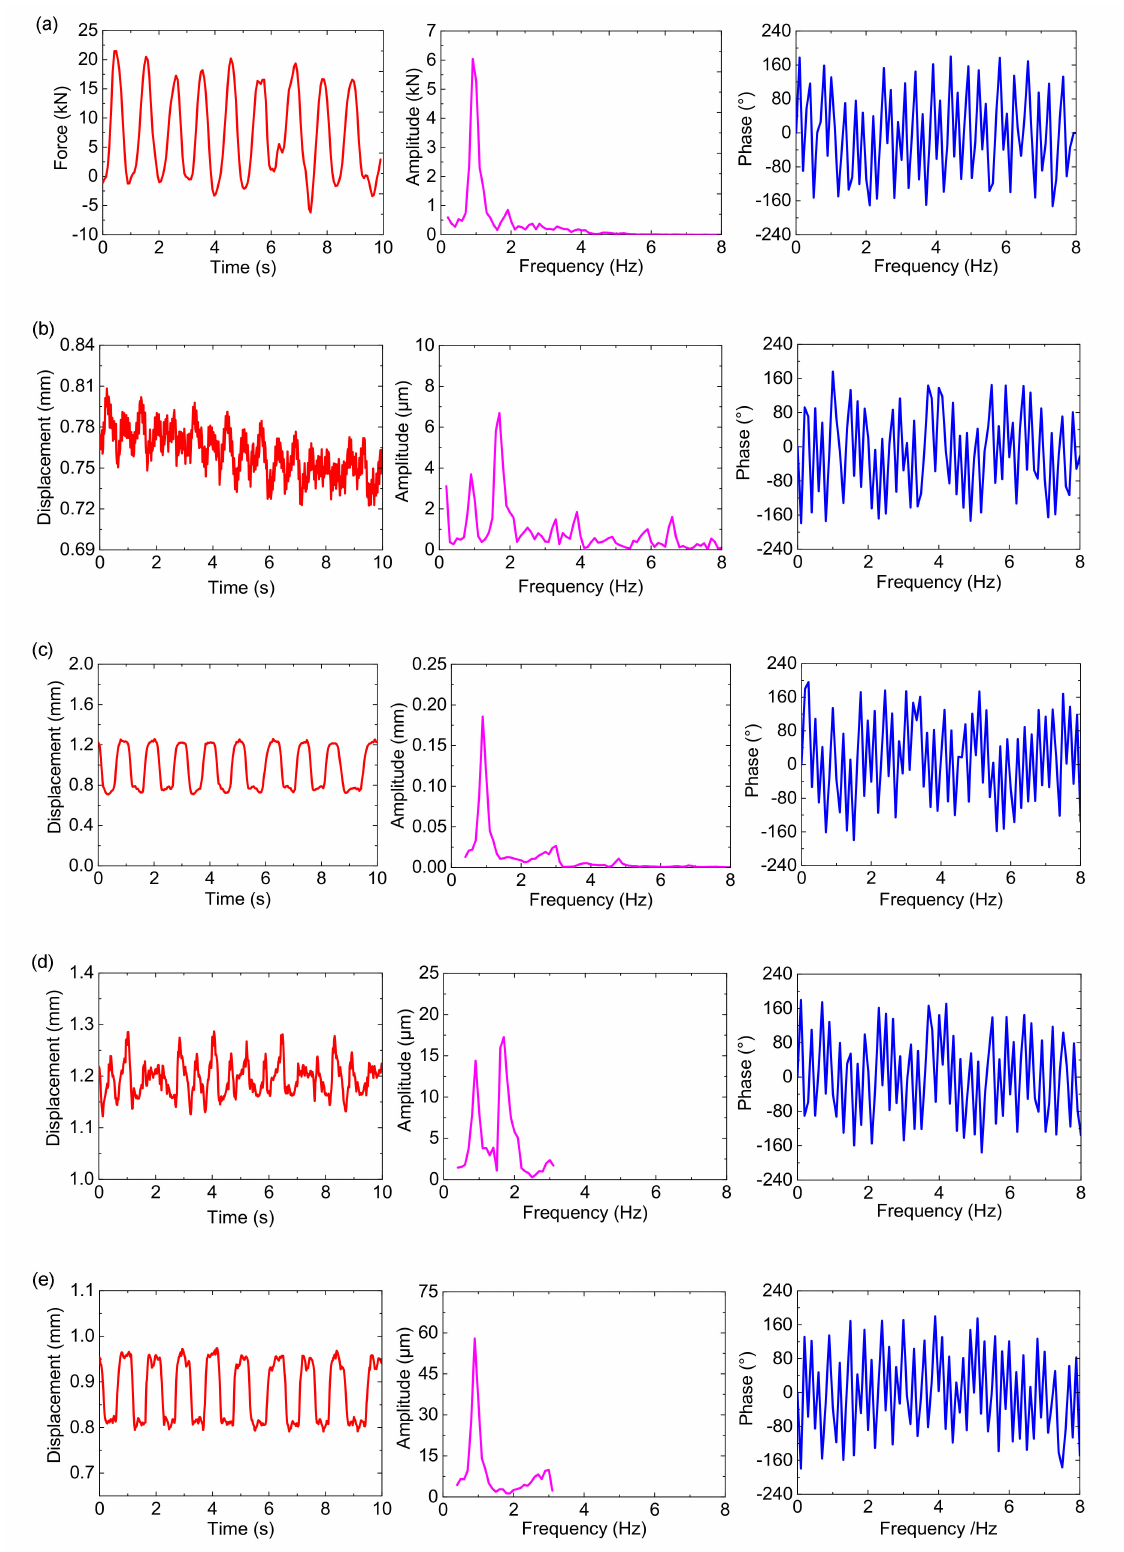
Figure 7. Time and frequency domain diagrams of 1 excitation force and 4 displacements: ( a ) Vertical excitation force; ( b ) horizontal displacement on the left side; ( c ) vertical displacement on the left side; ( d ) horizontal displacement on the right side; ( e ) vertical displacement on the right